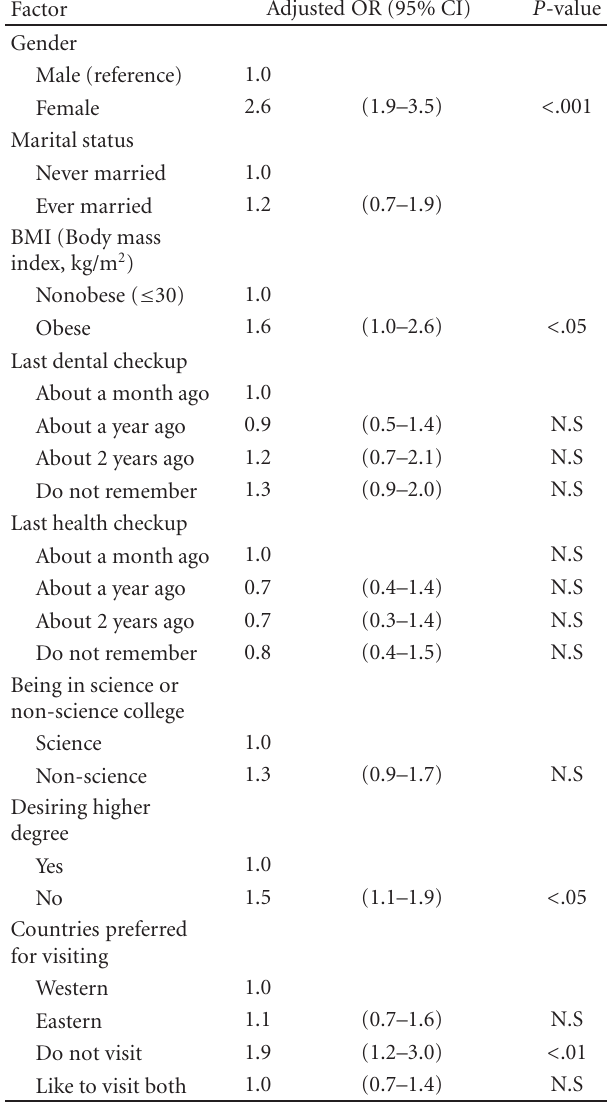
Table 2: Sociodemographic and health-related risk factors asso- ciated with physical inactivity of Kuwait University students ( n = 787). Logistic regression analysis